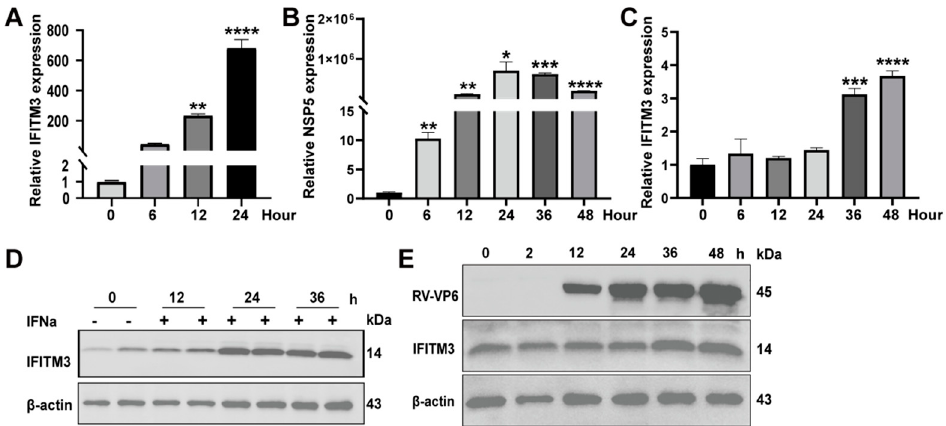
Figure 2. IFNa2b and RV promote the expression of IFITM3. ( A ) RT–qPCR analysis of IFITM3 in Caco2 cells after being incubated with IFNa2b (5000 U/mL) for the indicated time. ( B ) RT–qPCR analysis of the strain Wa–NSP5 in Caco2 cells infected with the strain Wa at 0.2 MOI for the indicated time. ( C ) RT–qPCR analysis of IFITM3 in Caco2 cells infected with the strain Wa at 0.2 MOI for the indicated time. ( D ) Western blot analysis of IFITM3 in Caco2 cells after being incubated with IFNa2b (5000 U/mL) for the indicated time. ( E ) Western blot analysis of the strain Wa–VP6 and IFITM3 in Caco2 cells infected with the Wa strain at 0.2 MOI for certain time ( A – C ) Results represented the mean ± SD and were measured in technical duplicates, n = 3. *, p < 0.05; **, p < 0.01; ***, p < 0.001 and ****, p < 0.0001 (Student’s t test).